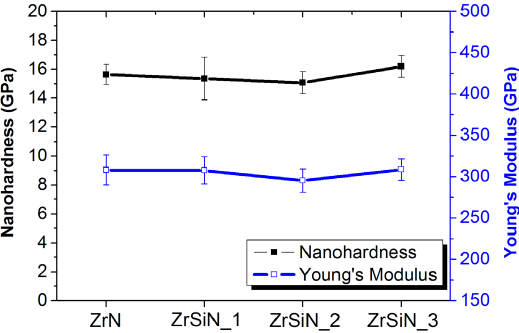
Figure 4. Nanohardness and Young’s Modulus – it is verified no significant changes for all films